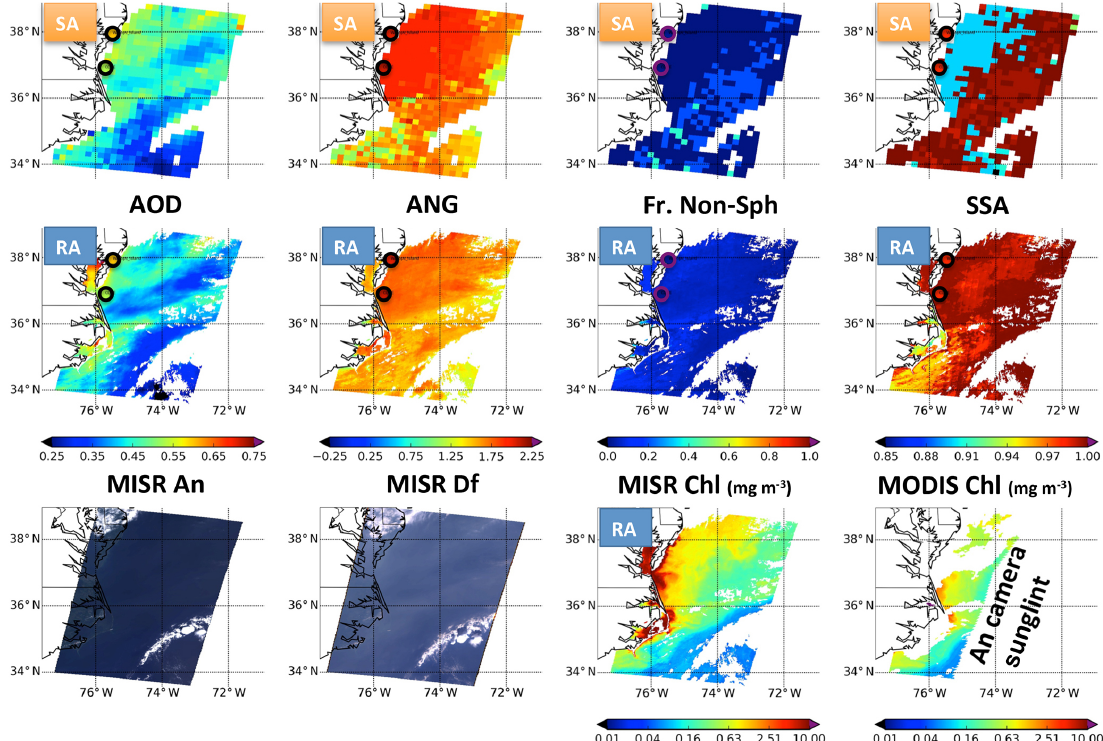
Figure 5. MISR imagery acquired on 26 August 2003, 15:51Z: Terra orbit 19620, MISR blocks 60–63, along the US east coast. Plots compare the MISR SA (at 17.6km resolution, top row) to the RA that includes retrieved Chl (at 1.1km resolution, row 2). AOD and particle properties correspond to the MISR green band (558nm). AERONET direct-sun and inversion values are shown for the COVE and Wallops stations as embedded circles. AERONET Fr. Non-Sph may not be informative when aerosol extinction is dominated by the fine mode. In the lower left, MISR An and Df RGB images are shown for context. MISR-retrieved Chl and MODIS-retrieved Chl are shown in the bottom right two